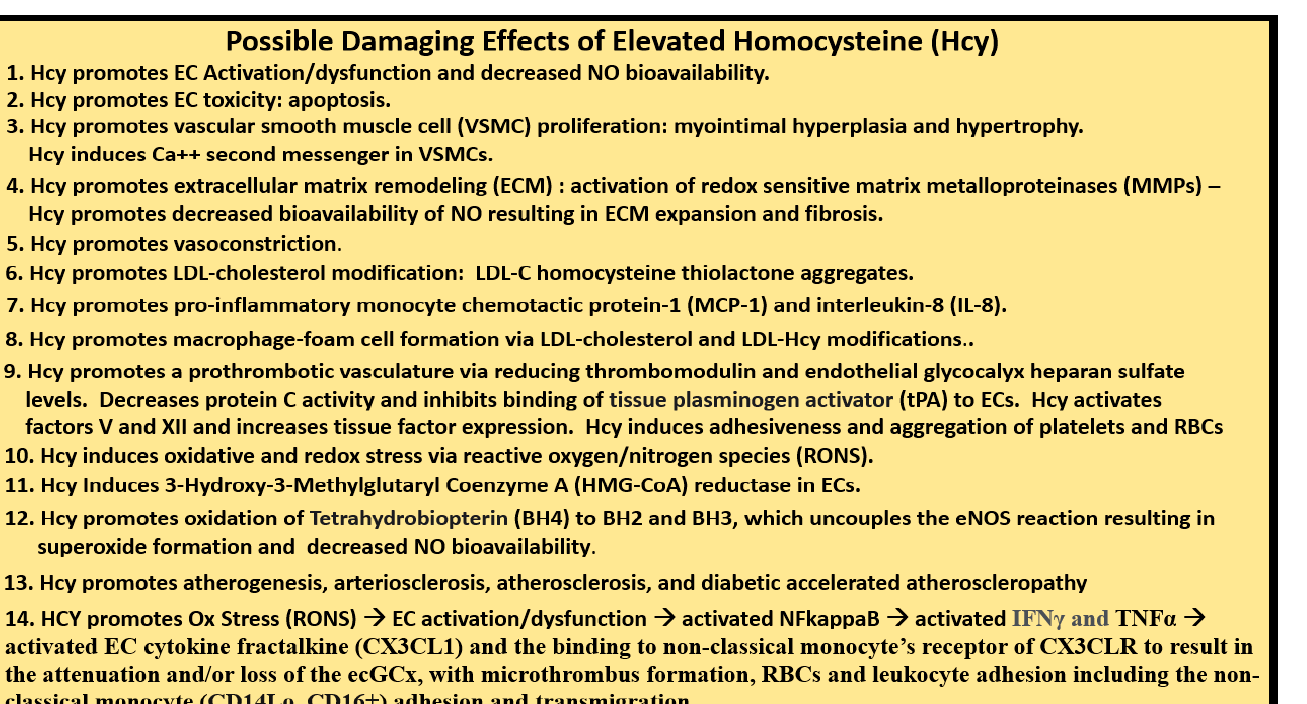
Figure 12. Possible Damaging Effects of Elevated Homocysteine (Hcy). There are at least 14 possible damaging effects of hyperhomocysteinemia (HHcy) to cells, tissues and organs. The possible dam- aging effects (1–13) are supported in reference [6], while the possible damaging effect of HHcy in number 14 is developed in the current review. Additionally, circulating monocytic SARS-CoV-2 spike protein remnants may also induce toxic cytokine/chemokine production in endothelial cells. CD14lo = cluster of differentiation 14 low; CD16+ = cluster of differentiation 16 positive; EC = endothelial cell; ecGCx = endothelial cell glycocalyx; eNOS = endothelial nitric oxide synthase; IFN γ = interferon gamma; LDL = low-density lipoprotein cholesterol; NO = nitric oxide; Ox = oxidative stress; RONS = reactive oxygen nitrogen species; NFkappaB = nuclear factor kappa B; RBCs = red blood cells; TNF α = tumor necrosis factor alpha.